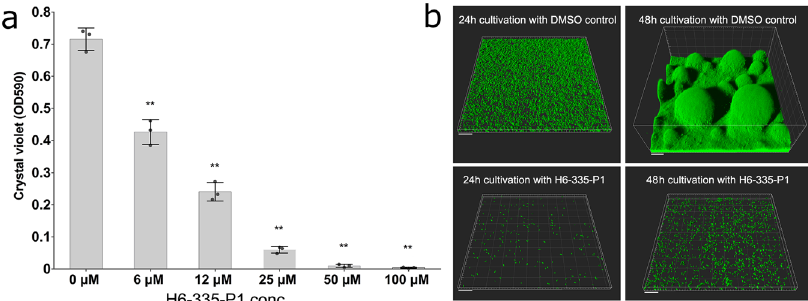
Fig. 4 H6-335-P1-mediated inhibition of P. aeruginosa bio fi lm formation. a P. aeruginosa was cultivated for 10 h in the wells of microtiter plates in the presence of various concentrations of H6-335-P1. Subsequently, the amounts of bio fi lm in the wells were quanti fi ed using a crystal violet assay. Mean and standard deviation (bars) of three biological replicates ( n = 3) are shown. One-way ANOVA analysis with Sidak ’ s multiple comparisons test was used to calculate signi fi cance values (** p < 0.01). b Gfp-tagged P. aeruginosa was cultivated in fl ow-cells perfused with growth medium with or without 25 μ M H6-336-P1. CLSM micrographs of the adherent bacteria were acquired after 24 and 48 h of cultivation. Simulated 3D fl uorescence projections were generated from the CLSM image stacks using IMARIS software. The size bars correspond to 20 μ m.